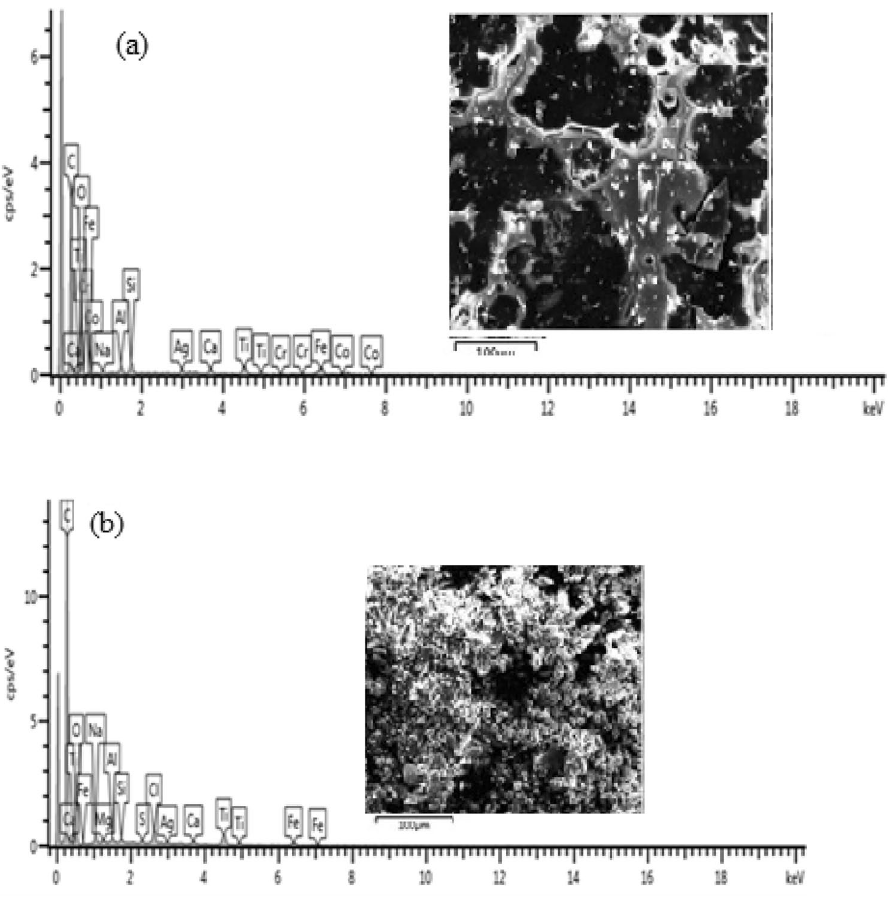
Figure 15. Energy diffraction spectron (EDS) of sample cured at 200 °C: ( a ) before corrosion and ( b ) after corrosion.